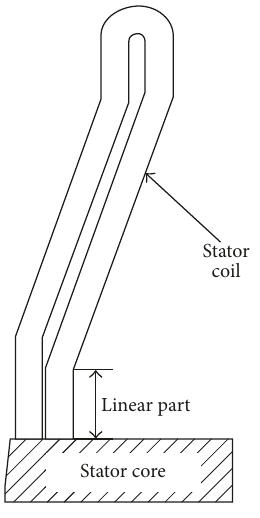
Figure 14: Definition of stator coil linear